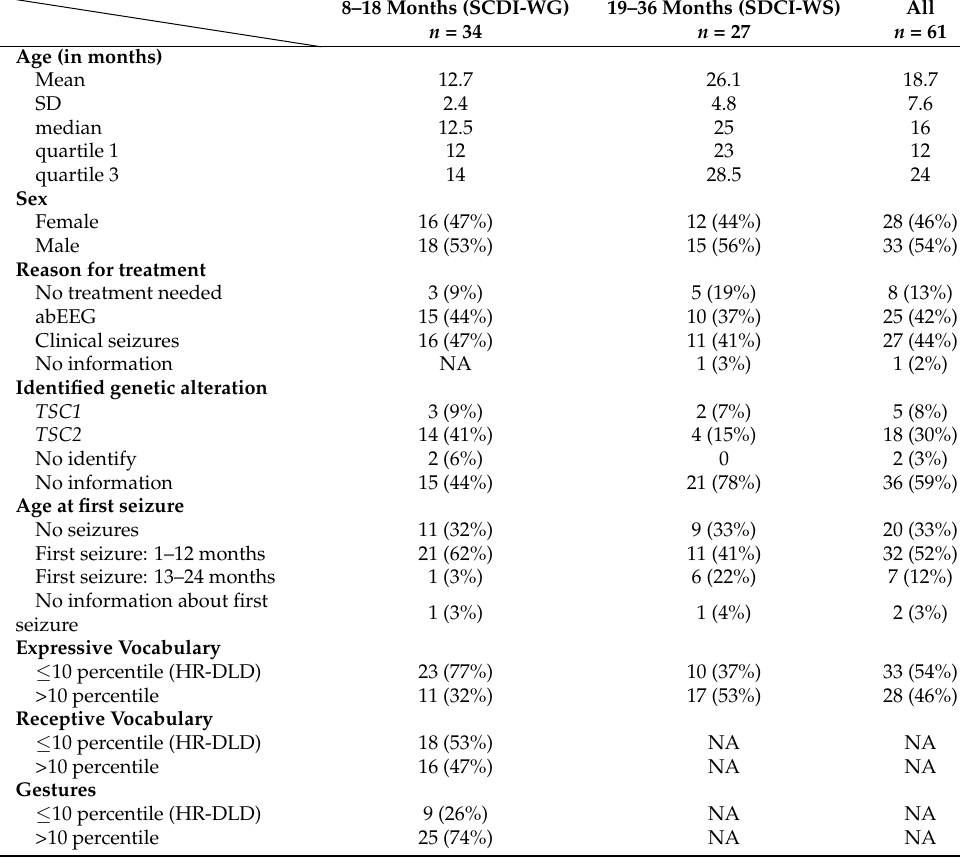
Table 1. Descriptive statistics for age of the study participants and number of study participants with regard to sex, the reason for treatment introduction, genetic alteration, age of the first occurrence of seizures and risk of delayed language